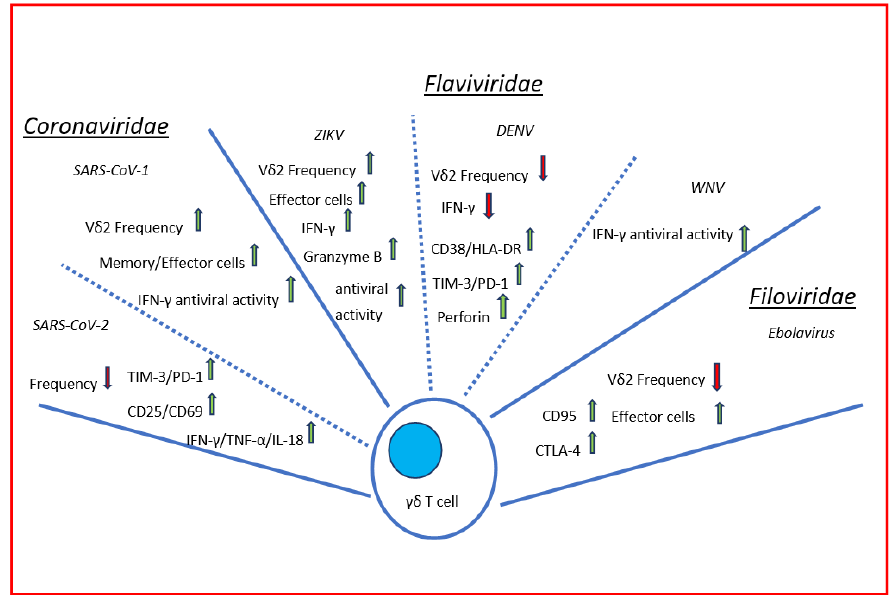
Figure 1. Immune response of human γδ T cells to viral emerging infections. Briefly, γδ T cells are able to recognize cells infected with emerging viruses belonging to Coronaviridae , Flaviviridae, and Filoviridae families and exert their antiviral activity by cytolytic and non-cytolytic mechanisms. During the infection, γδ T-cell frequency decreased/increased depending on the emerging virus. Regardless, γδ T cells differentiate in activated memory/effector (CD25, CD69, CD38, HLA-DR, and CD95 expression) cells after interaction with the pathogen and release large amount of pro-inflammatory cytokines (IFN- γ , TNF- α , IL-18) and cytotoxic soluble factors (Perforin and Granzyme B). Through all these factors, γδ T cells exert their potent antiviral activity. During the infections, γδ T cells express exhaustion markers (PD -1, TIM-3), as other circulating T αβ cells , dampening their effector functions.